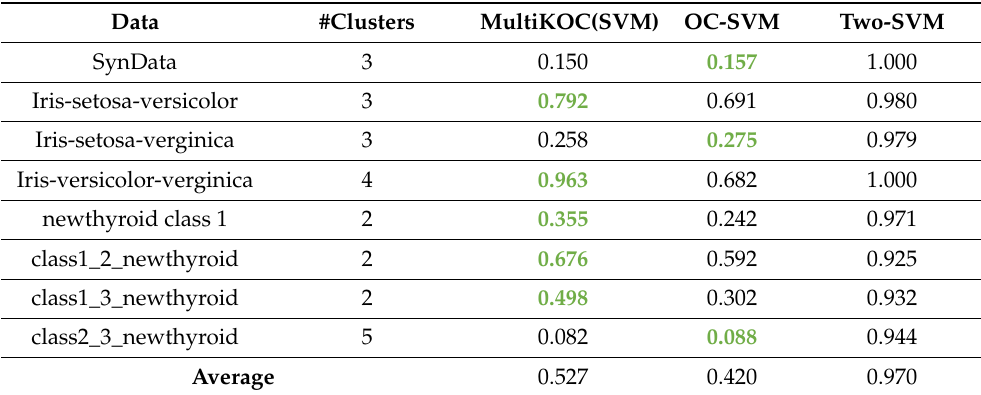
Table 4. Results summary for Support Vector Machine classifier. The column #clusters is the optimal number of clusters obtained for MultiKOC.